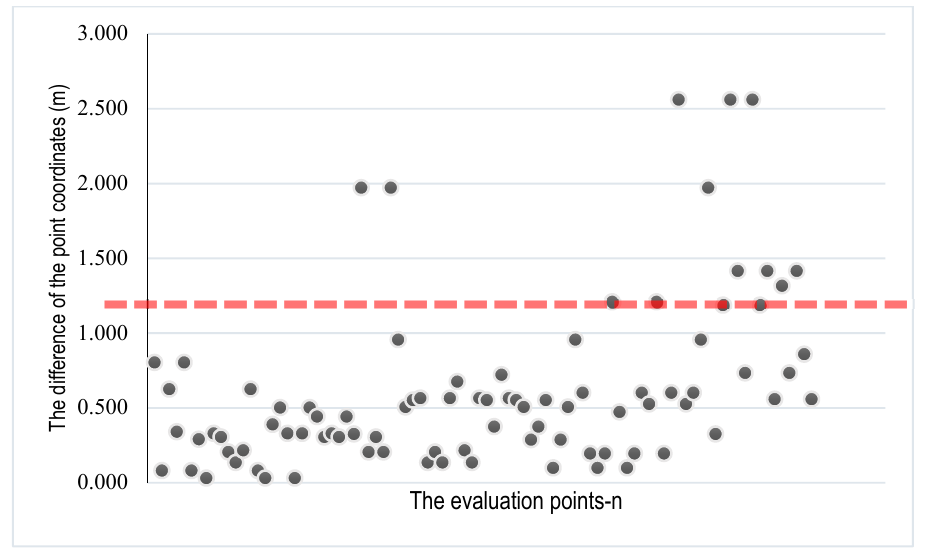
Figure A1. Positional accuracy (in meters) plotted as a shifting of points between the reference and evaluation data for paddy fields in Grobogan.